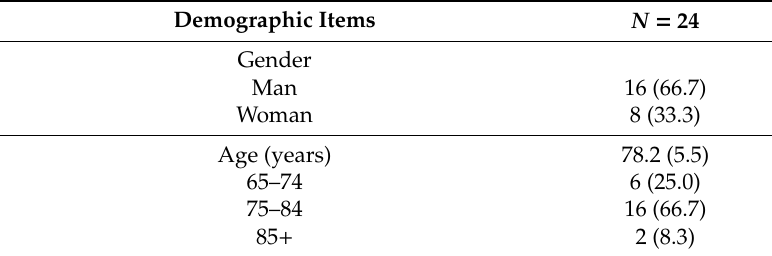
Table 1. Participants’ demographic